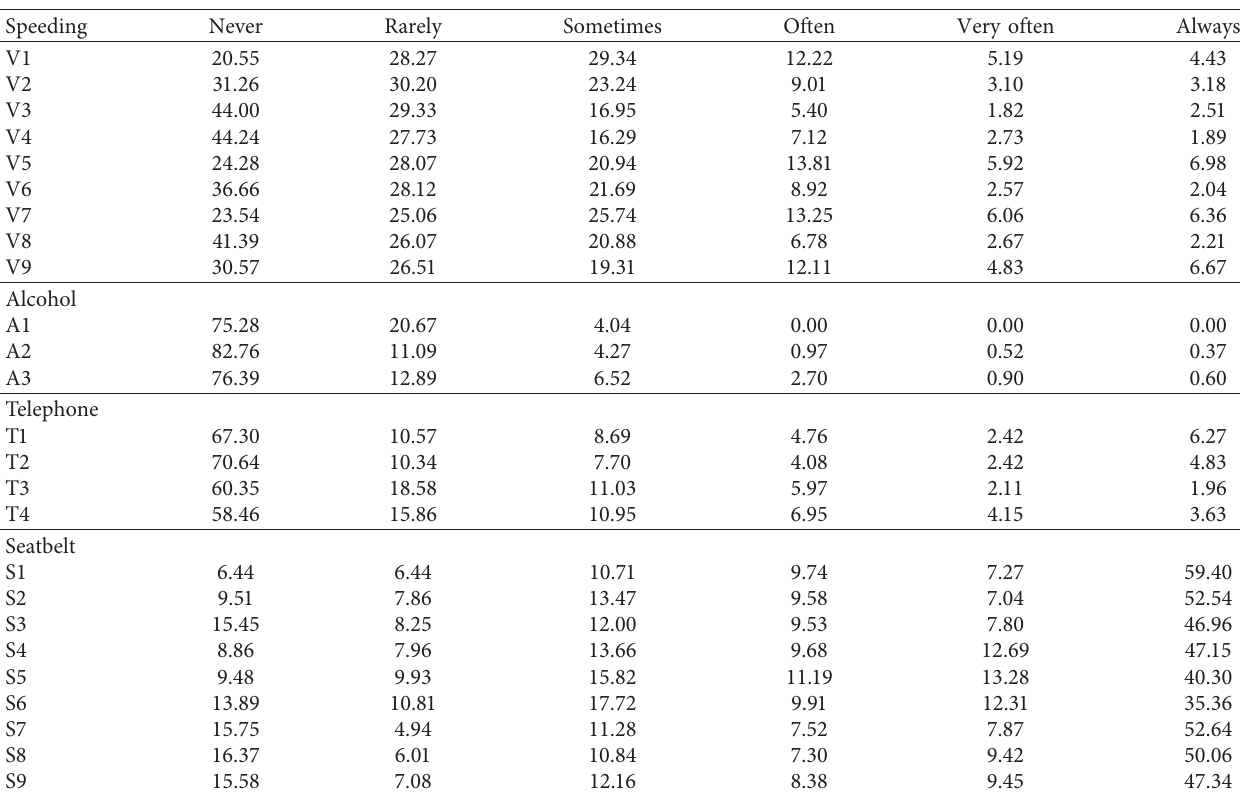
Table 5: Collected answers (in %).